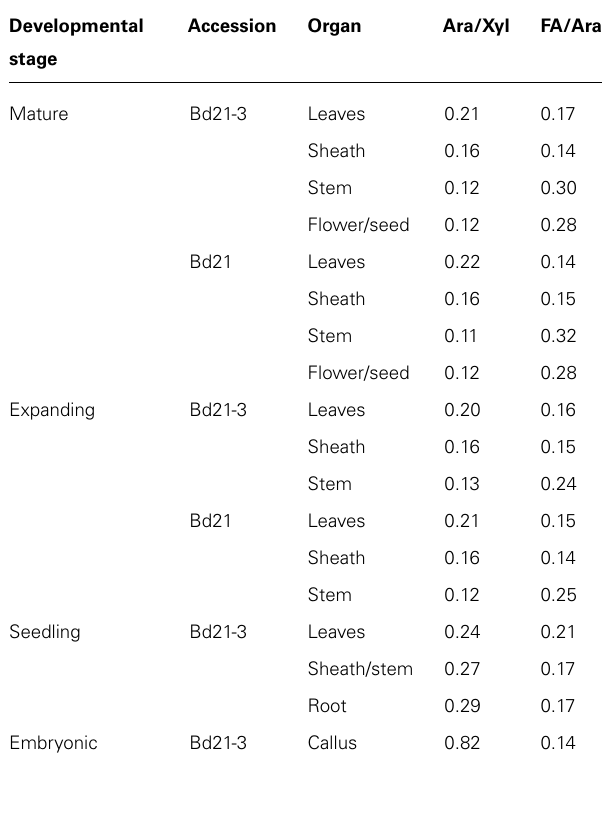
Table 5 |Ara/Xyl and FA/Ara cell wall molar